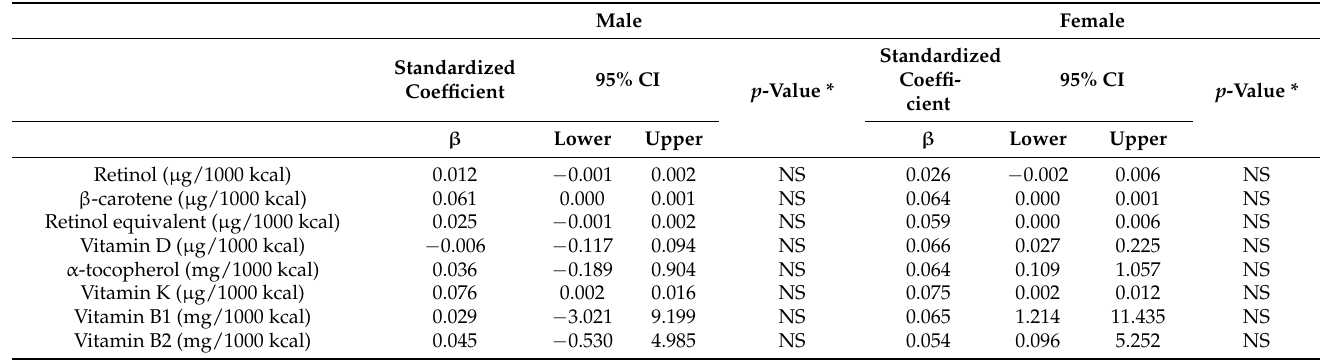
Table 6. Association between nutrient intakes and Mental Component Summary